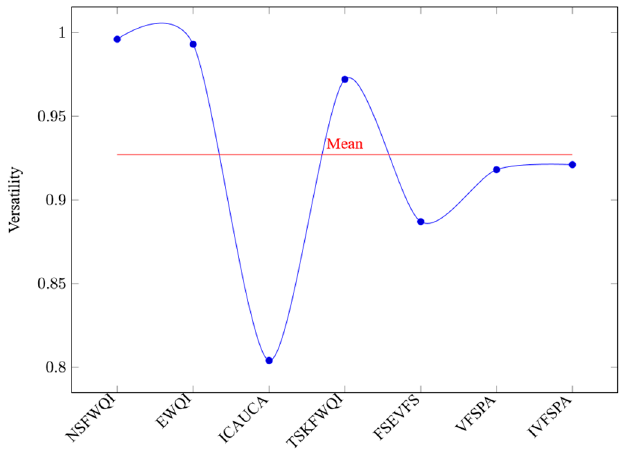
Figure 9. Versatility values.